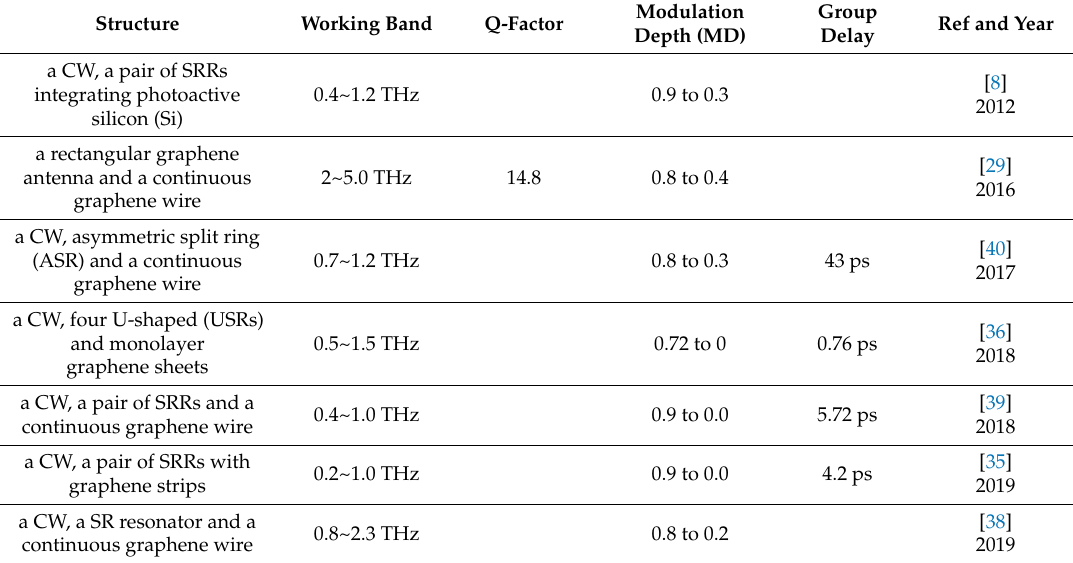
Table 2. The performance comparison of various PIT metamaterial structures with working band, Q-factor, modulation depth (MD), group